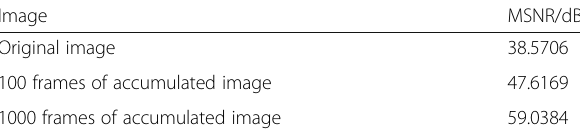
Table 2 The mean signal-to-noise ratios (MSNRs) of the original single-channel image and the N-frames accumulated image